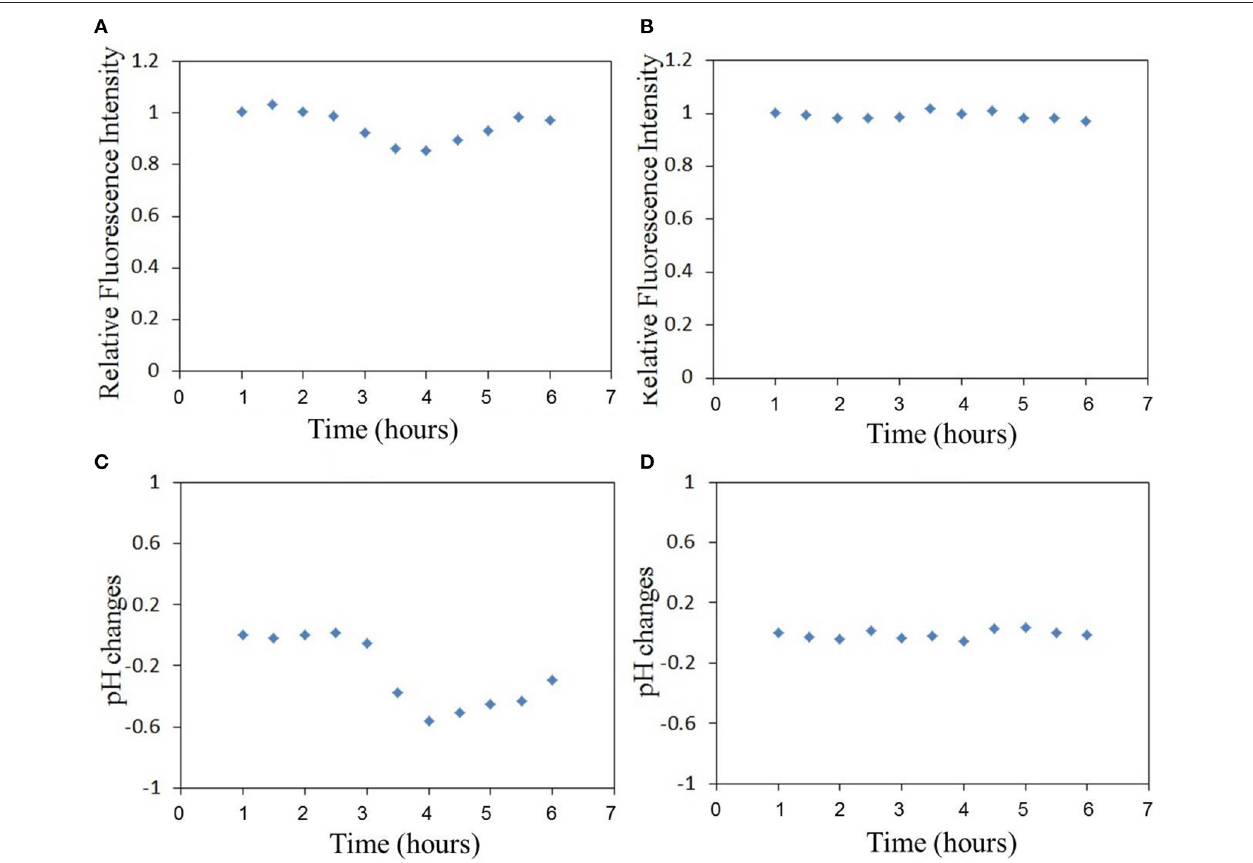
FIGURE 4 | The relative fluorescence intensity changes of FITC of the sensor adhered to (A) virus-bound cell and (B) virus-unbound cell, and the pH e changes of (C) virus-bound cell and (D) virus-unbound cell calculated basing on the fluorescence changes in (A,B), (Time-course measurements are initiated post-virus binding to the cell membrane).